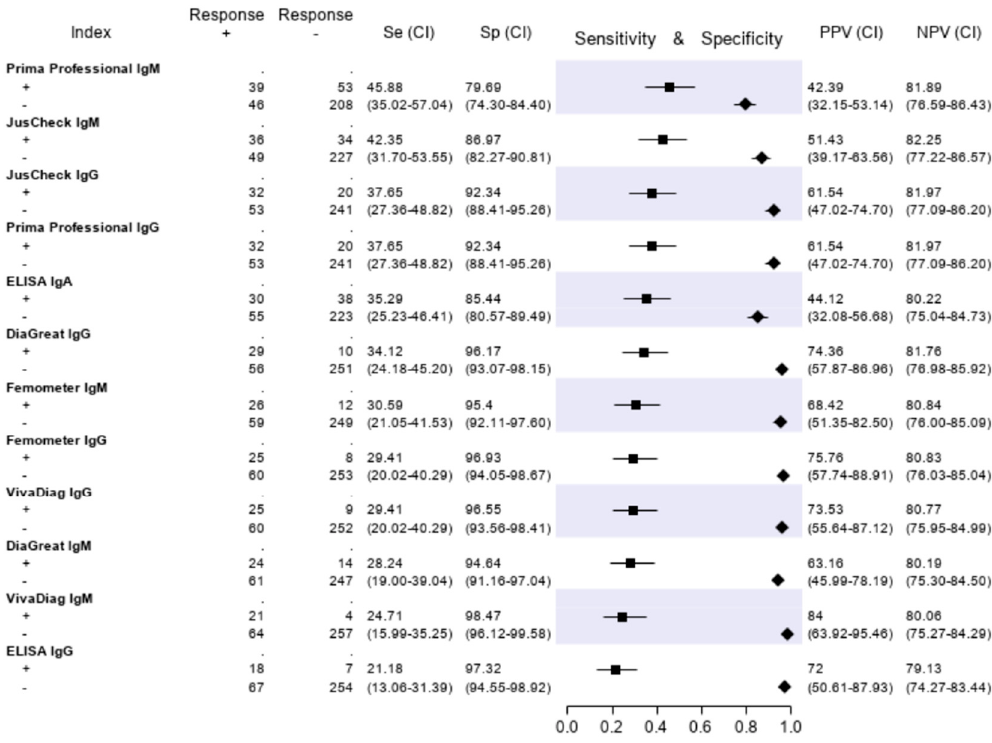
Figure 5. Sensitivity (filled squares), specificity (filled rhombus) and predictive values of six antibody tests according to the final classification (Infected = 85, not infective = 261).